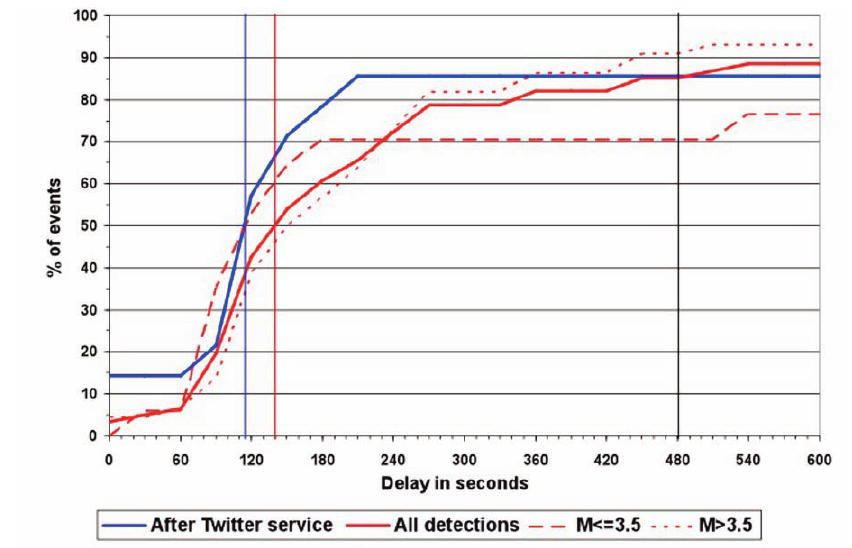
Figure 8. Distribution of the time benefit of using flash-sourcing for earthquake information. The time benefit is defined as the delay between the detection of the felt earthquake through the website traffic surge it generates and the publication of the first preliminary location and magnitude on the website. The time benefit is null for earthquakes that were first reported by the seismological networks. The blue line is the cumulative distribution since the initiation of the Twitter service, and the red line is for the period January 2009 to May 2011. The median time benefit is around 2 min. This can be much longer, especially for small magnitude earthquakes: it exceeds 8 minutes (480 s) for 30% of earthquake below M 3.5, as compared to 10% for larger shocks.